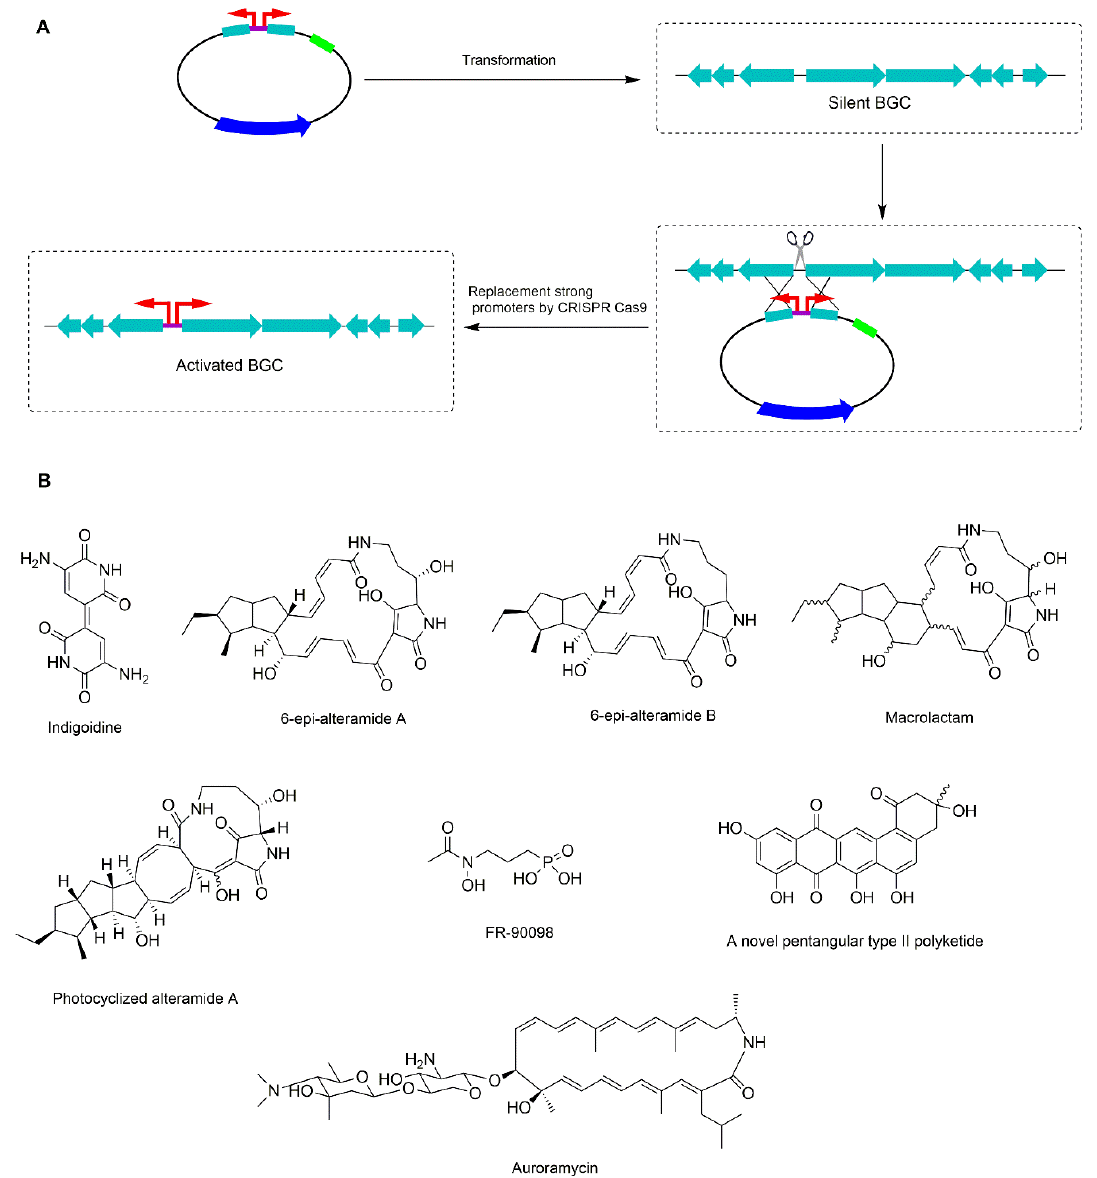
Figure 3. Overview of promoter replacement strategy using CRISPR-Cas9 technique. ( A ) Promoter replacement strategy using CRISPR-Cas9 technique. The dark blue arrows represent for Cas9 gene. The green arrows represent for gRNA. The light blue arrows represent for homology arms. ( B ) Structure of compounds are activated by promoter replacement strategy.